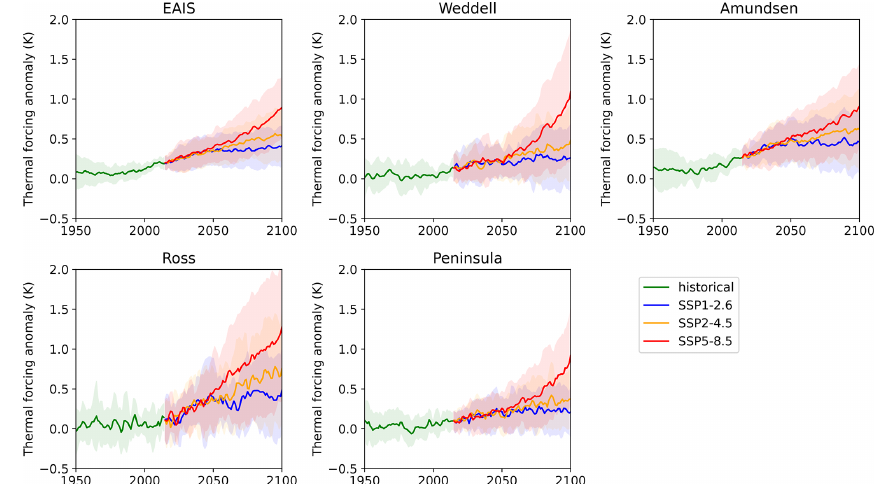
Figure 4. Thermal forcing anomalies centred around the mean depth of the ice shelf base for SSP1-2.6, SSP2-4.5 and SSP5-8.5 including all evaluated CMIP6 ESMs (Table 1) from 1950 to 2100 relative to the baseline period 1850–1930. The shaded regions indicate the intermodel spread (17th to 83rd percentiles) in ocean subsurface temperature between the ESMs.